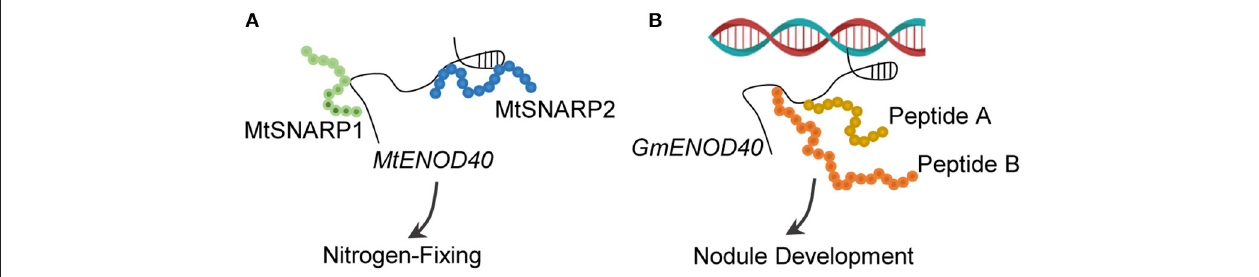
FIGURE 6 | LncRNA–peptide relations. (A) MtENOD40 acts as a decoy to titrate two small peptides, namely, MtSNARP1 and MtSNARP2. Both peptides play a key role in establishing nitrogen-fixing symbiosis between Medicago truncatula and Sinorhizobium meliloti. (B) GmENOD40 contains sORFs that encode two small peptides (Peptide A and Peptide B) of 12 and 24 amino acids each. Both peptides involve in the development of nitrogen-fixing nodules. competitively bind AtNSRs with AS targets in vitro and in vivo , regulating transcriptome diversity in the formation of lateral root development (Bardou et al., 2014). Additionally, ASCO binds with multiple splicing factors including PRP8a and SmD1b and modulates the spliced genes in response to bacterial flagellin (Rigo et al., 2020) ( Figure 5C ). ASCO acts as an integrator through interacting with the spliceosome to dynamically modulate the transcriptome